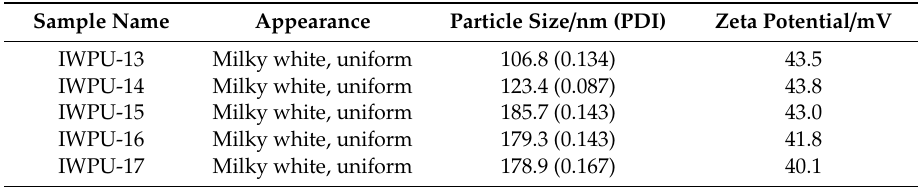
Table 3. Appearance and stability of IWPUs.